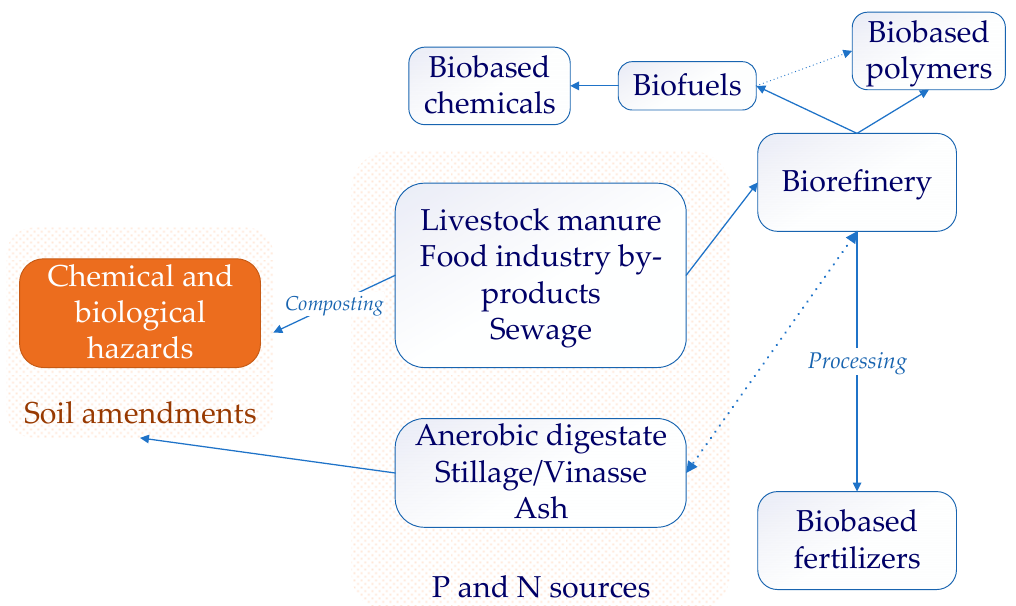
Figure 2. Advantages of the biorefinery approach that recover mineral nutrients as bio-based fertilizers and convert organic carbon into low-volume, high added-value products, including biodegradable bio-based polymers and biofuels that could be used as platform molecules for production of bio-based chemicals. Table 3. Recovery of phosphorus, nitrogen, and sulfur and other nutrients from biorefinery